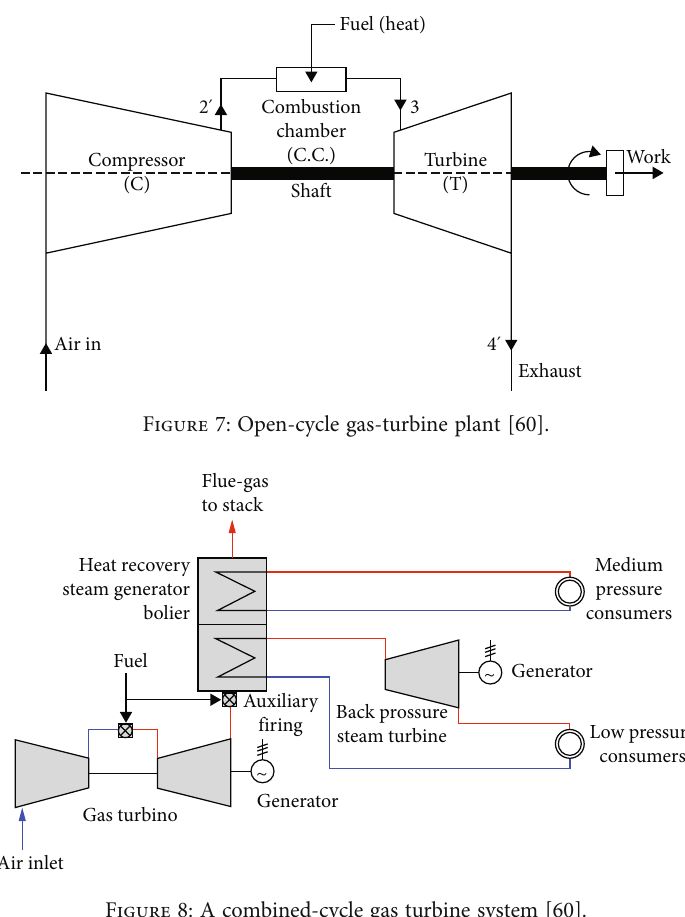
Figure 8: A combined-cycle gas turbine system [60].